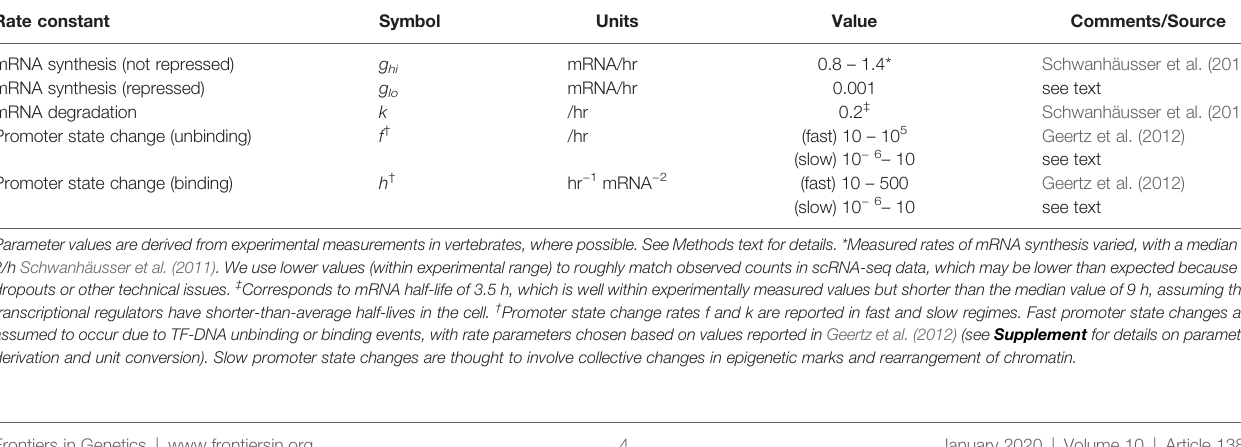
TABLE 1 | Rate Parameters used in gene regulatory network models.